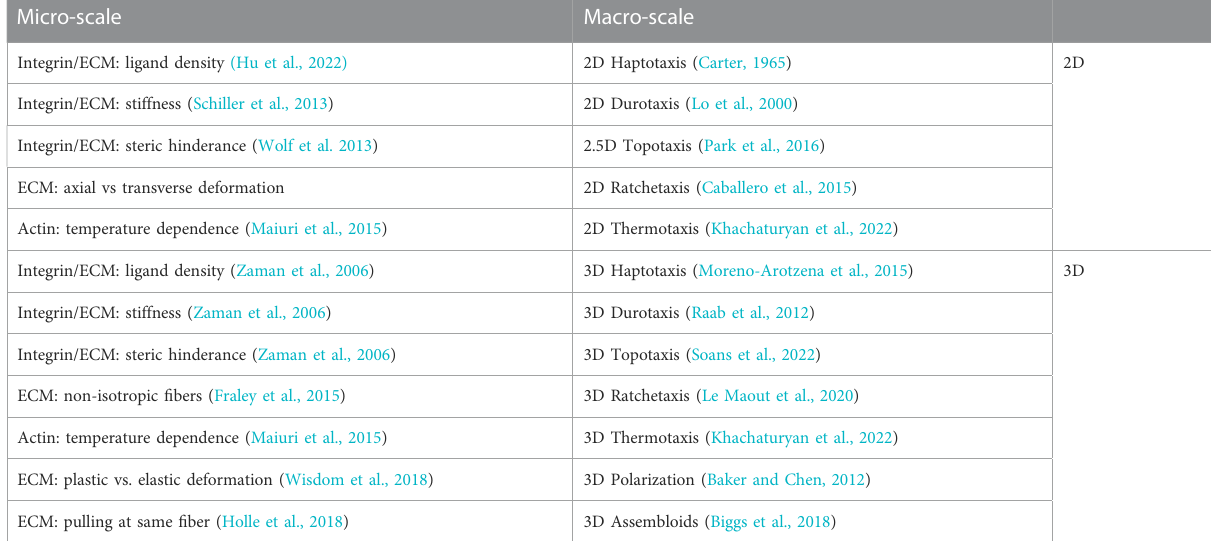
TABLE 1Modulating cell dynamics atthe micro-scaleandatthe macro-scale.Top panels depicting how changesin 2Dsubstrateproperties alter leading edge dynamics(left),aswellassomeofthecorrespondingchangesinmotionpattern(right).Below,changesincelldynamicsatthemicro-scale(left)andemerging properties that may arise at the macro-scale (right) are indicated for cells cultured in